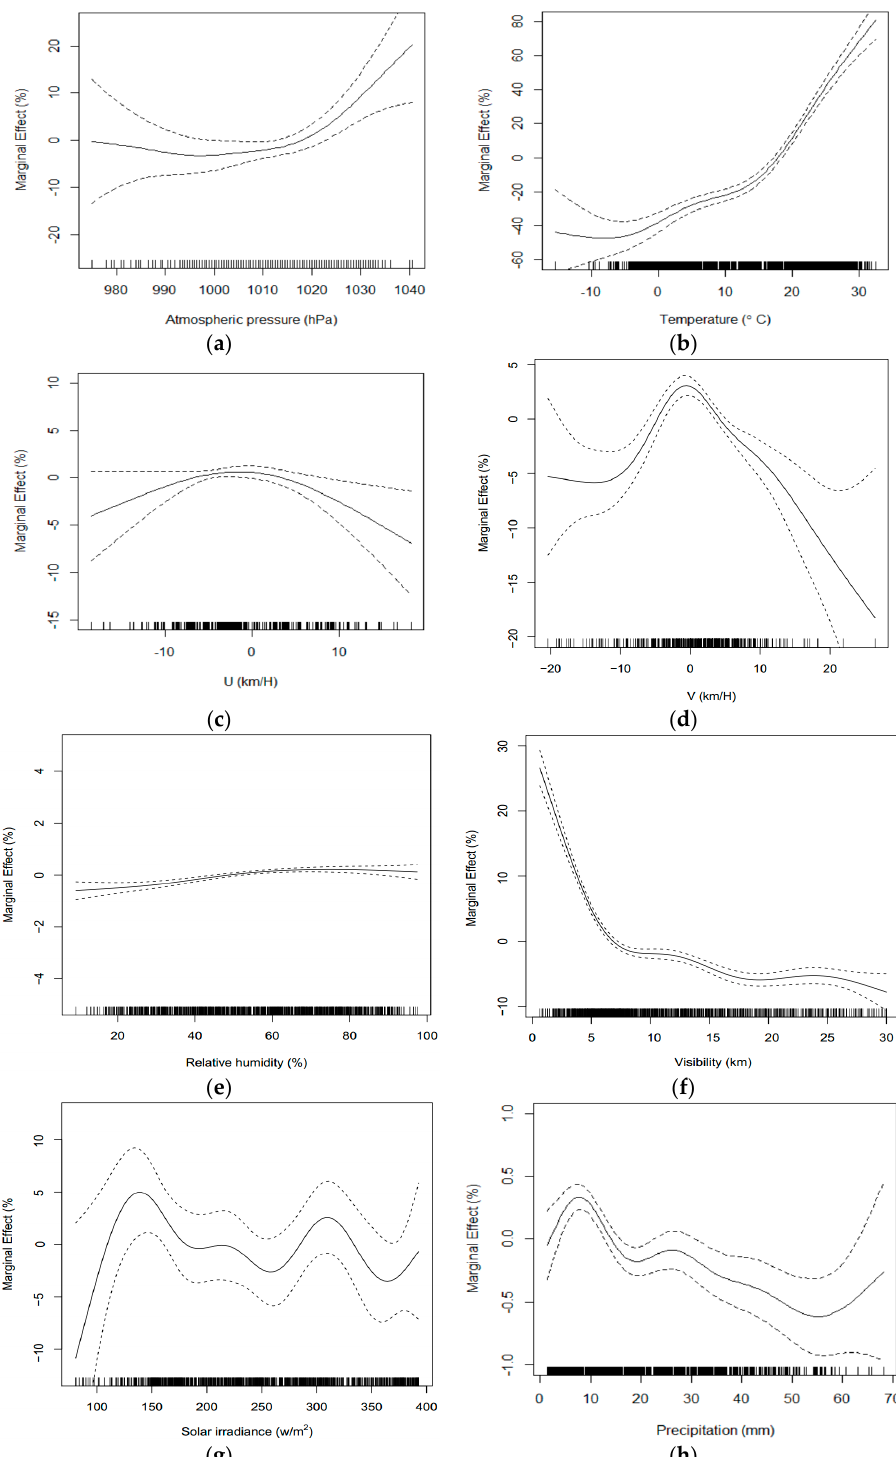
Figure 5. Partial residual plot for CO. ( a ) atmospheric pressure; ( b ) temperature; ( c ) zonal ( u ) wind; ( d ) meridional ( v ) wind; ( e ) relative humidity; ( f ) visibility; ( g ) solar irradiance; ( h ) precipitation. The abscissa represents the magnitude of each meteorological variable. The ordinate represents the marginal effect, which is the impact of various meteorological variables on air pollutants. The dashed line is the 95% confidence interval and the short line perpendicular to the abscissa represents the distribution frequency of each meteorological